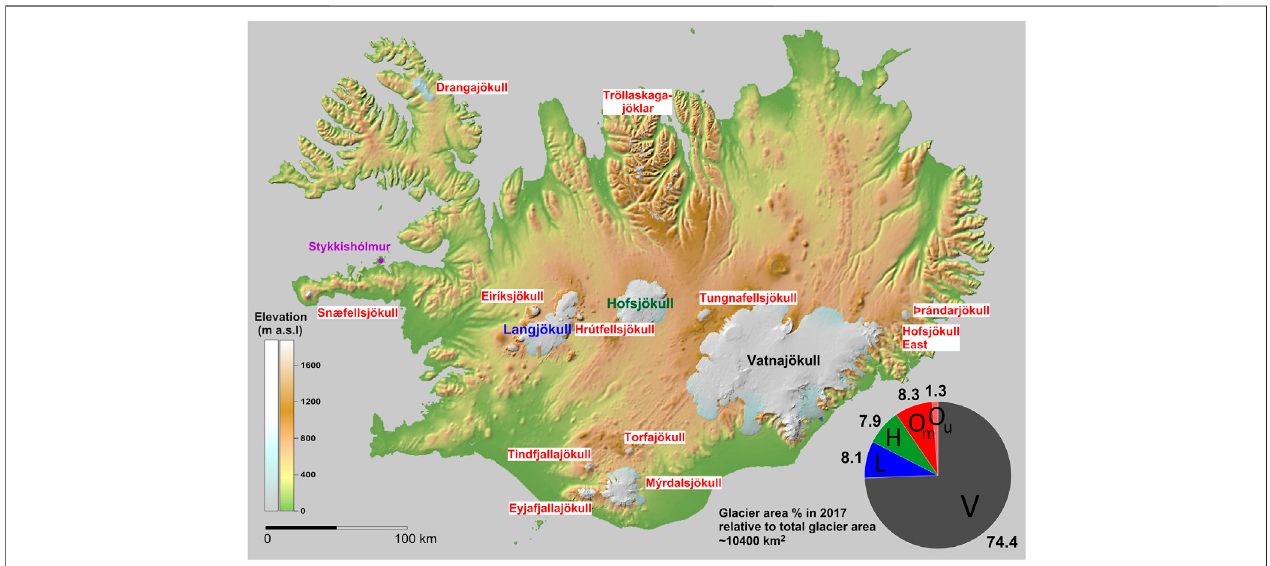
FIGURE 1 | Map of Iceland showing the glaciers considered in this study. The pie chart in the bottom right corner shows the relative sizes of the glaciers in 2017 (Hannesdóttir et al., 2020) in percentage; Vatnajökull (V), Langjökull (L), Hofsjökull (H), and the smaller glaciers grouped as O m in pie chart: Drangajökull, Snæfellsjökull, Eyjafjallajökull, Tindfjallajökull, Torfajökull, Mýrdalsjökull, Þrándarjökull, Hofsjökull eystri, Tungnafellsjökull, Hrútfellsjökull, Eiríksjökull and Barkárdals- and Tungnahryggsjökull, considered as one glacier unit on Tröllaskagi. Unmeasured glaciers (O u ) corresponded to ∼ 1.3% of the total area in 2019 (Hannesdóttir et al., 2020). The town Stykkishólmur is shown with a purple dot, from which a temperature record exists since the middle of the 19th century.